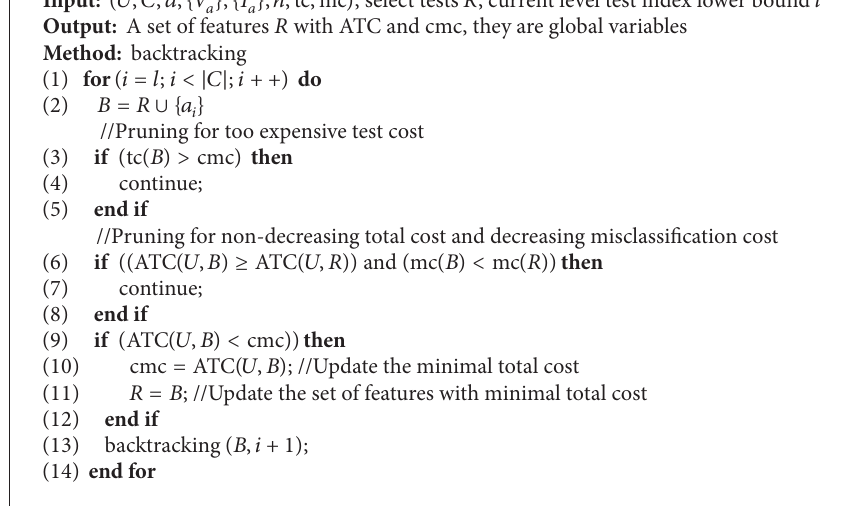
Algorithm 1: A backtracking algorithm to the FSMC problem.